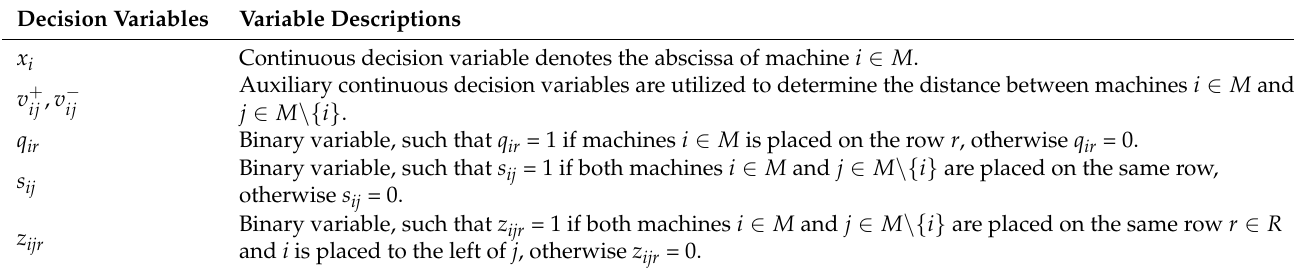
Table 1. Decision